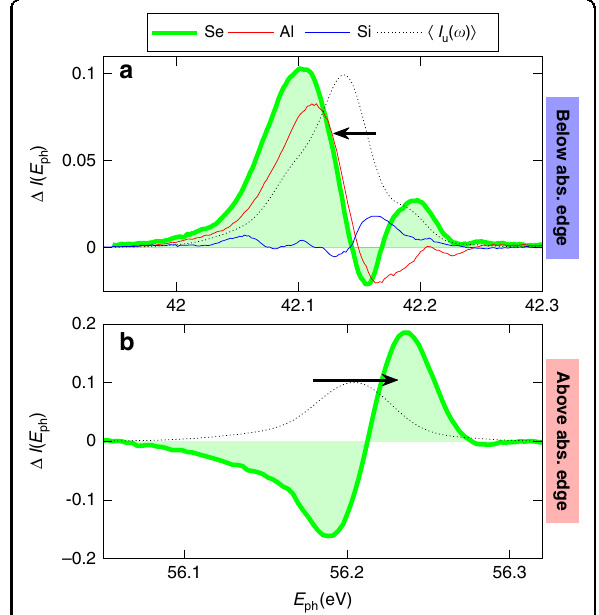
Fig. 3 Spectral modi fi cation in sub-micrometric fi lms. a The difference of normalized spectra before and after the sample interaction in a 300 nm Al fi lm (red line), 100 nm of Si (blue line), and 120 nm of Se (green area) at 42.1 eV with a fl uence of 31 J cm − 2 . b The measurement is performed in Se fi lm above the M 4,5 absorption edge (at 55 eV) with a fl uence of 9 J cm − 2 . 〈 I u ( E ph ) 〉 of the sample, divided by a factor 10, is depicted by the black dotted lines. The horizontal black arrows indicate the shift